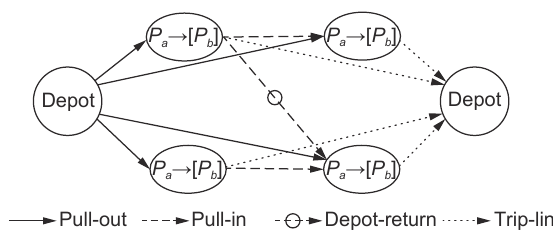
Fig. 1 A network flow for